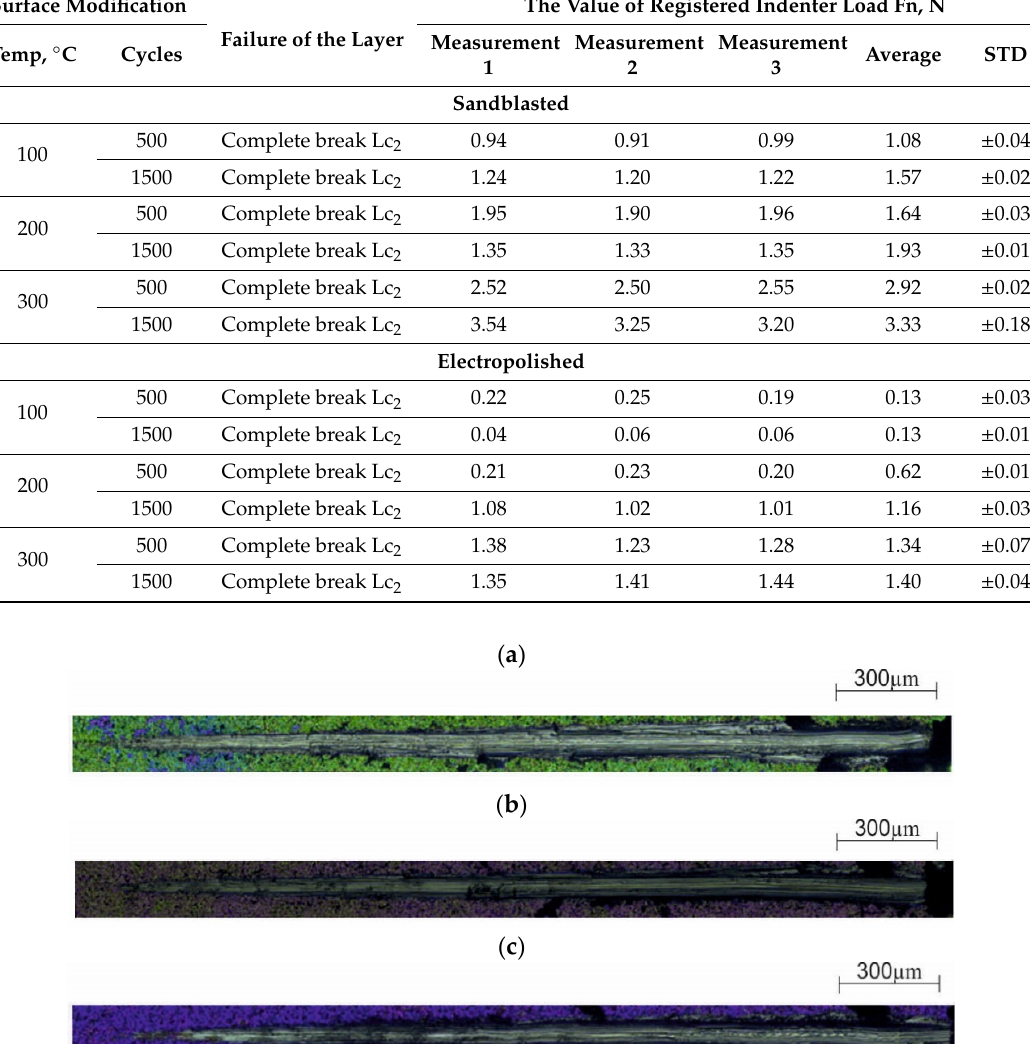
Table 3. The adhesion of the ZnO layer to the substrate made of 316 LVM steel.